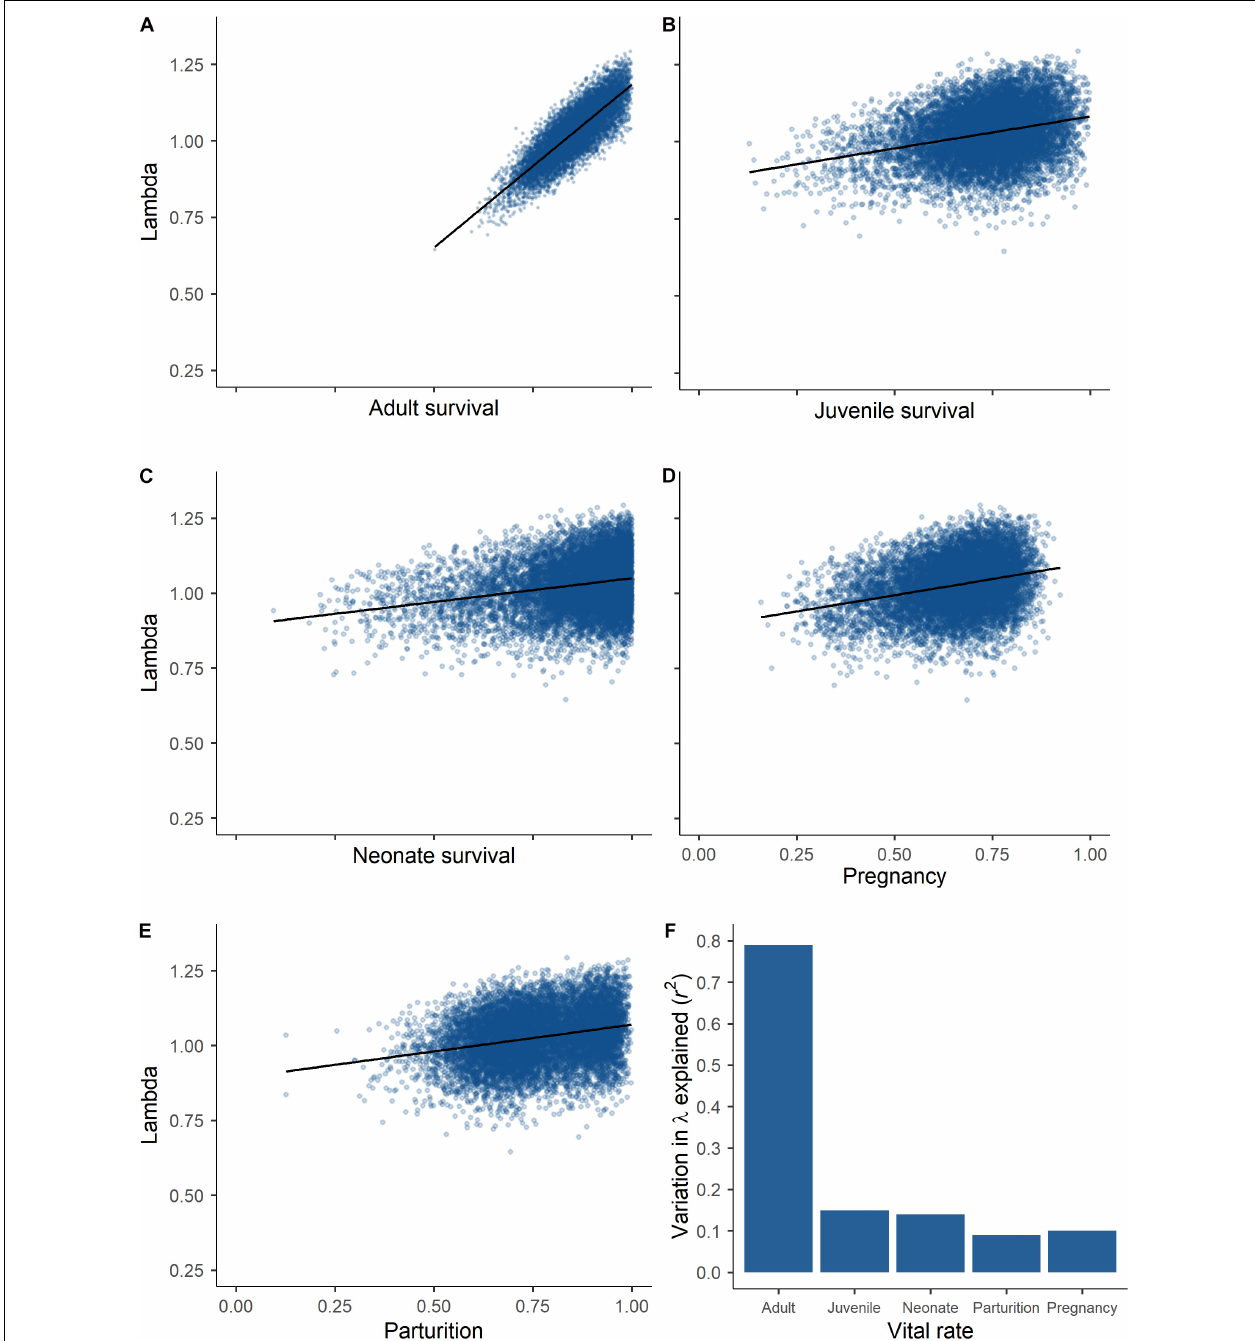
FIGURE 3 | Results from life stage simulation analysis for moose in Sublette from 2011 to 2014, showing the variation in lambda explained by (A) adult ( > 2.5 years) survival ( r 2 = 0.70), (B) juvenile survival ( r 2 = 0.08), (C) neonate survival ( r 2 = 0.06), (D) pregnancy status ( r 2 = 0.08), (E) parturition status ( r 2 = 0.07), and (F) proportion of variation in λ explained by each vital rate (see Table 2 for annual estimates) in western Wyoming, United